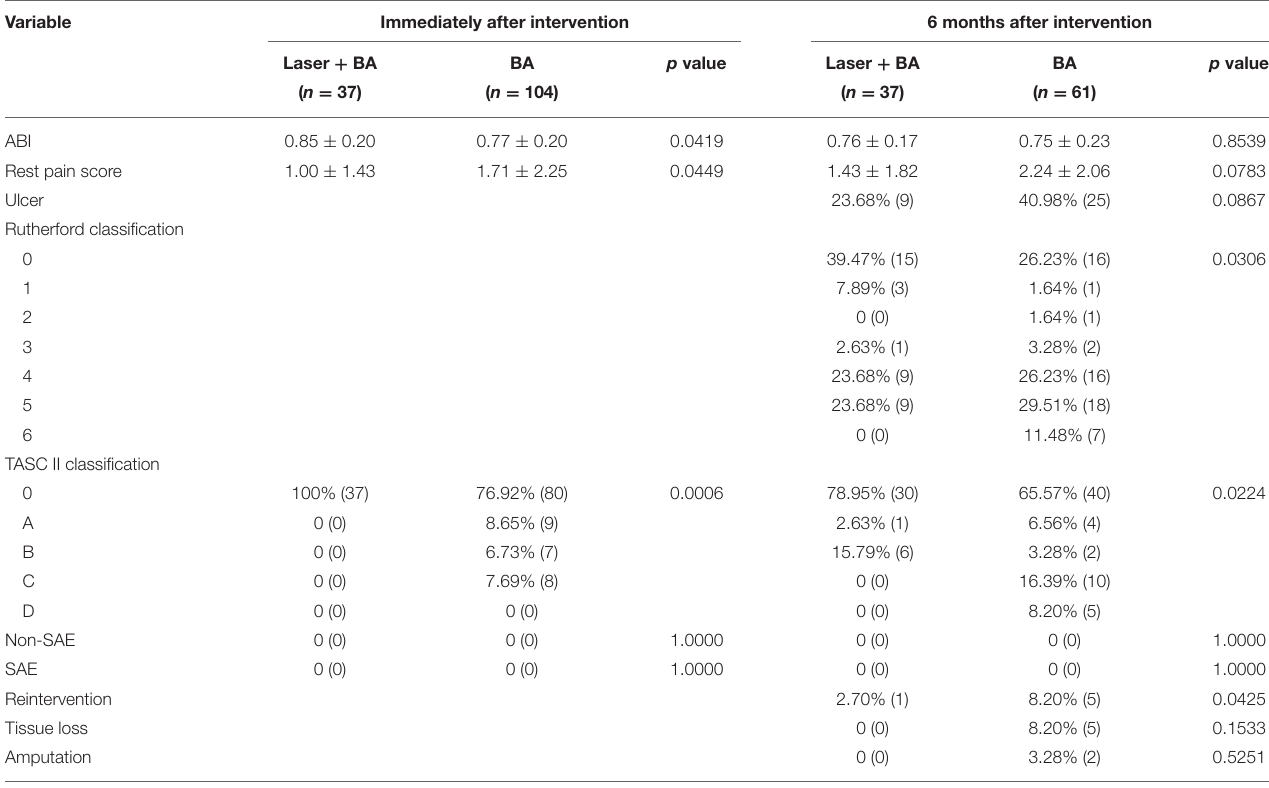
TABLE 3 | The clinical outcomes of patients with TAO received laser-assisted angioplasty and BA alone.